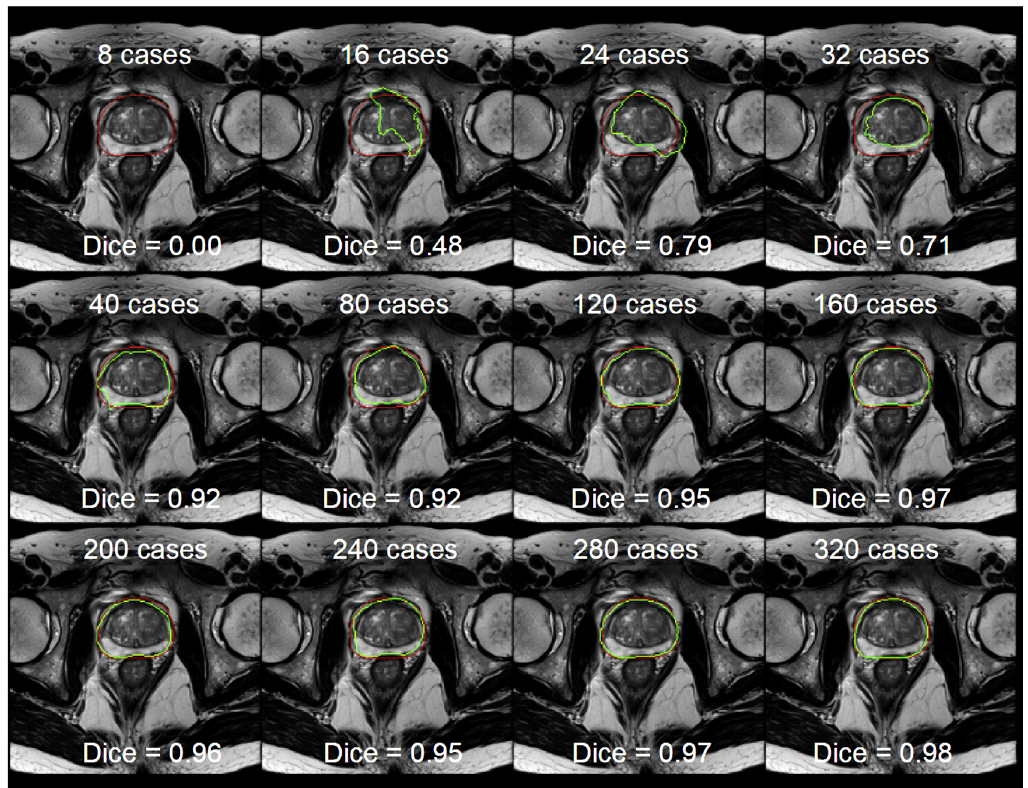
Figure 4. The performance of the U-Net was plotted for one axial slice on a single case across the different training sizes. The red line is the ground truth and the green line is the U-Net. The Dice score for one axial slice is shown in each square. The Dice score started to stabilize once the neural network trained with 160 cases.